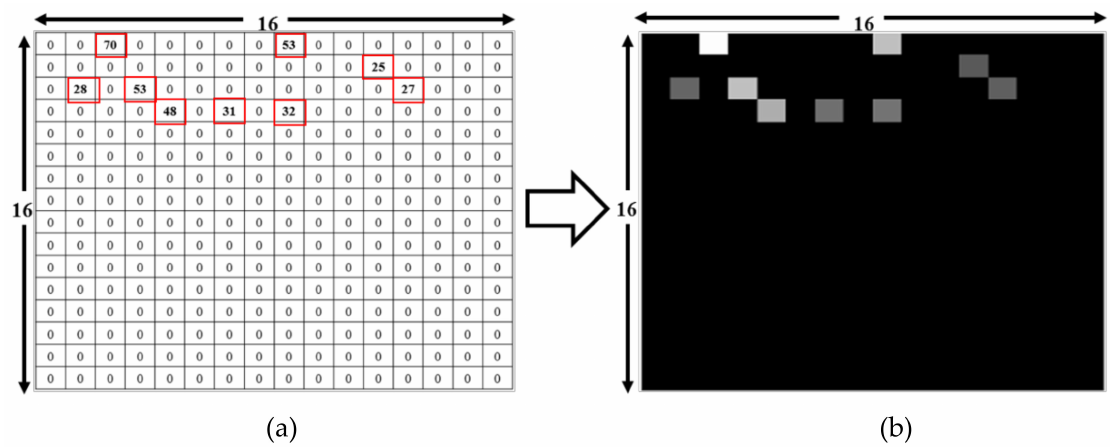
Figure 1. Deep learning input file conversion from 256 received signal strength indicator (RSSI) values to a 16 × 16 image. ( a ) Input comma-separated values (CSV) readings of the nine visible RSSIs from a total of 256 access points (APs). ( b ) Converted grayscale image with nine bright spots representing APs visible at the reference point (RP)